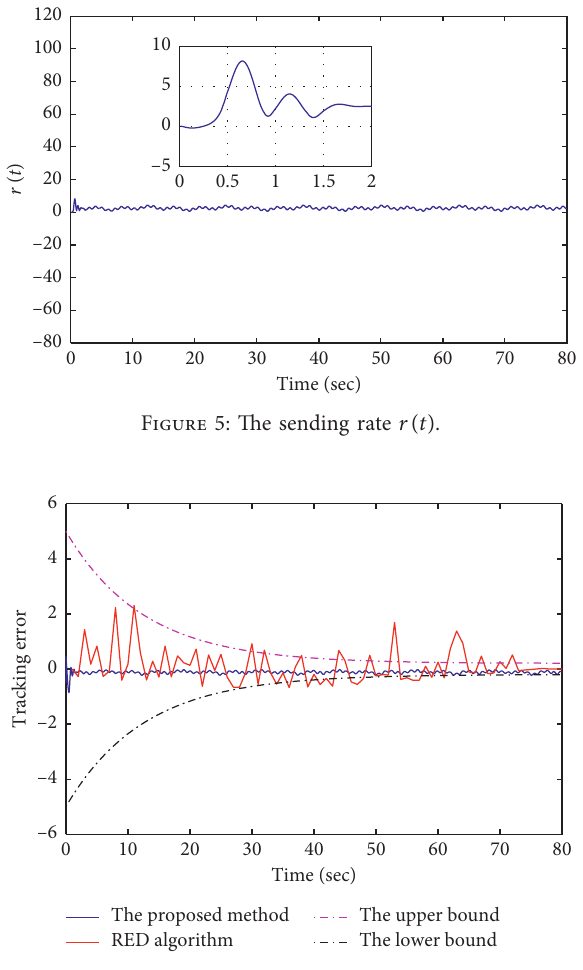
Figure 6: The comparison results with the tracking